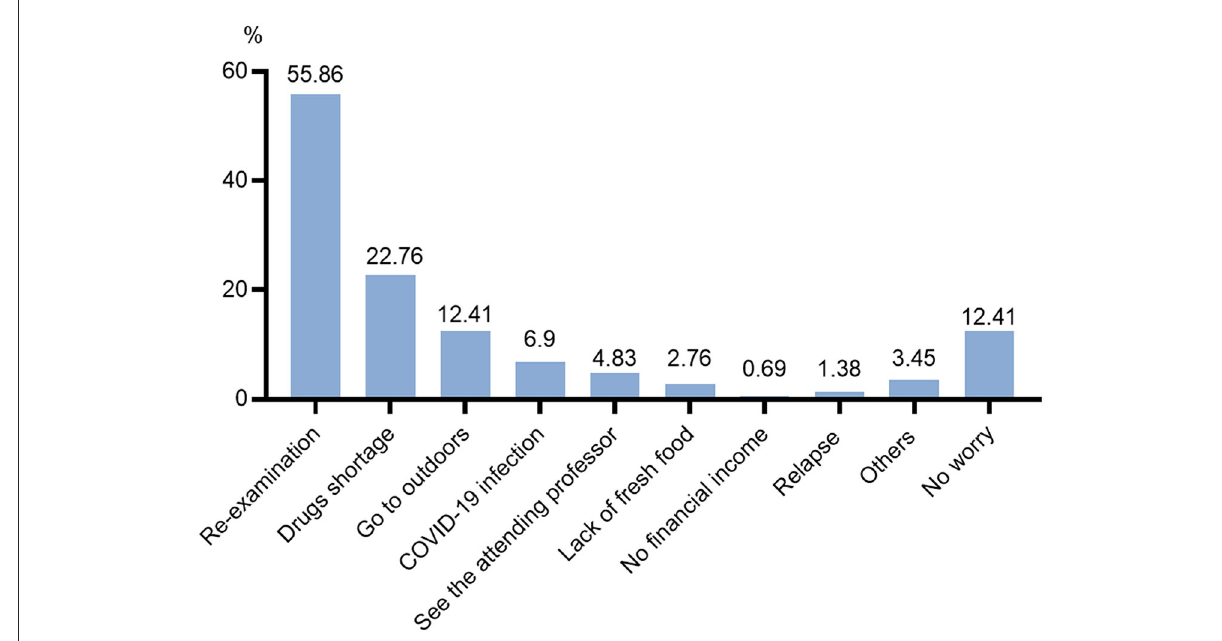
FIGURE5 The biggest fear of the participants during the COVID-19 epidemic.